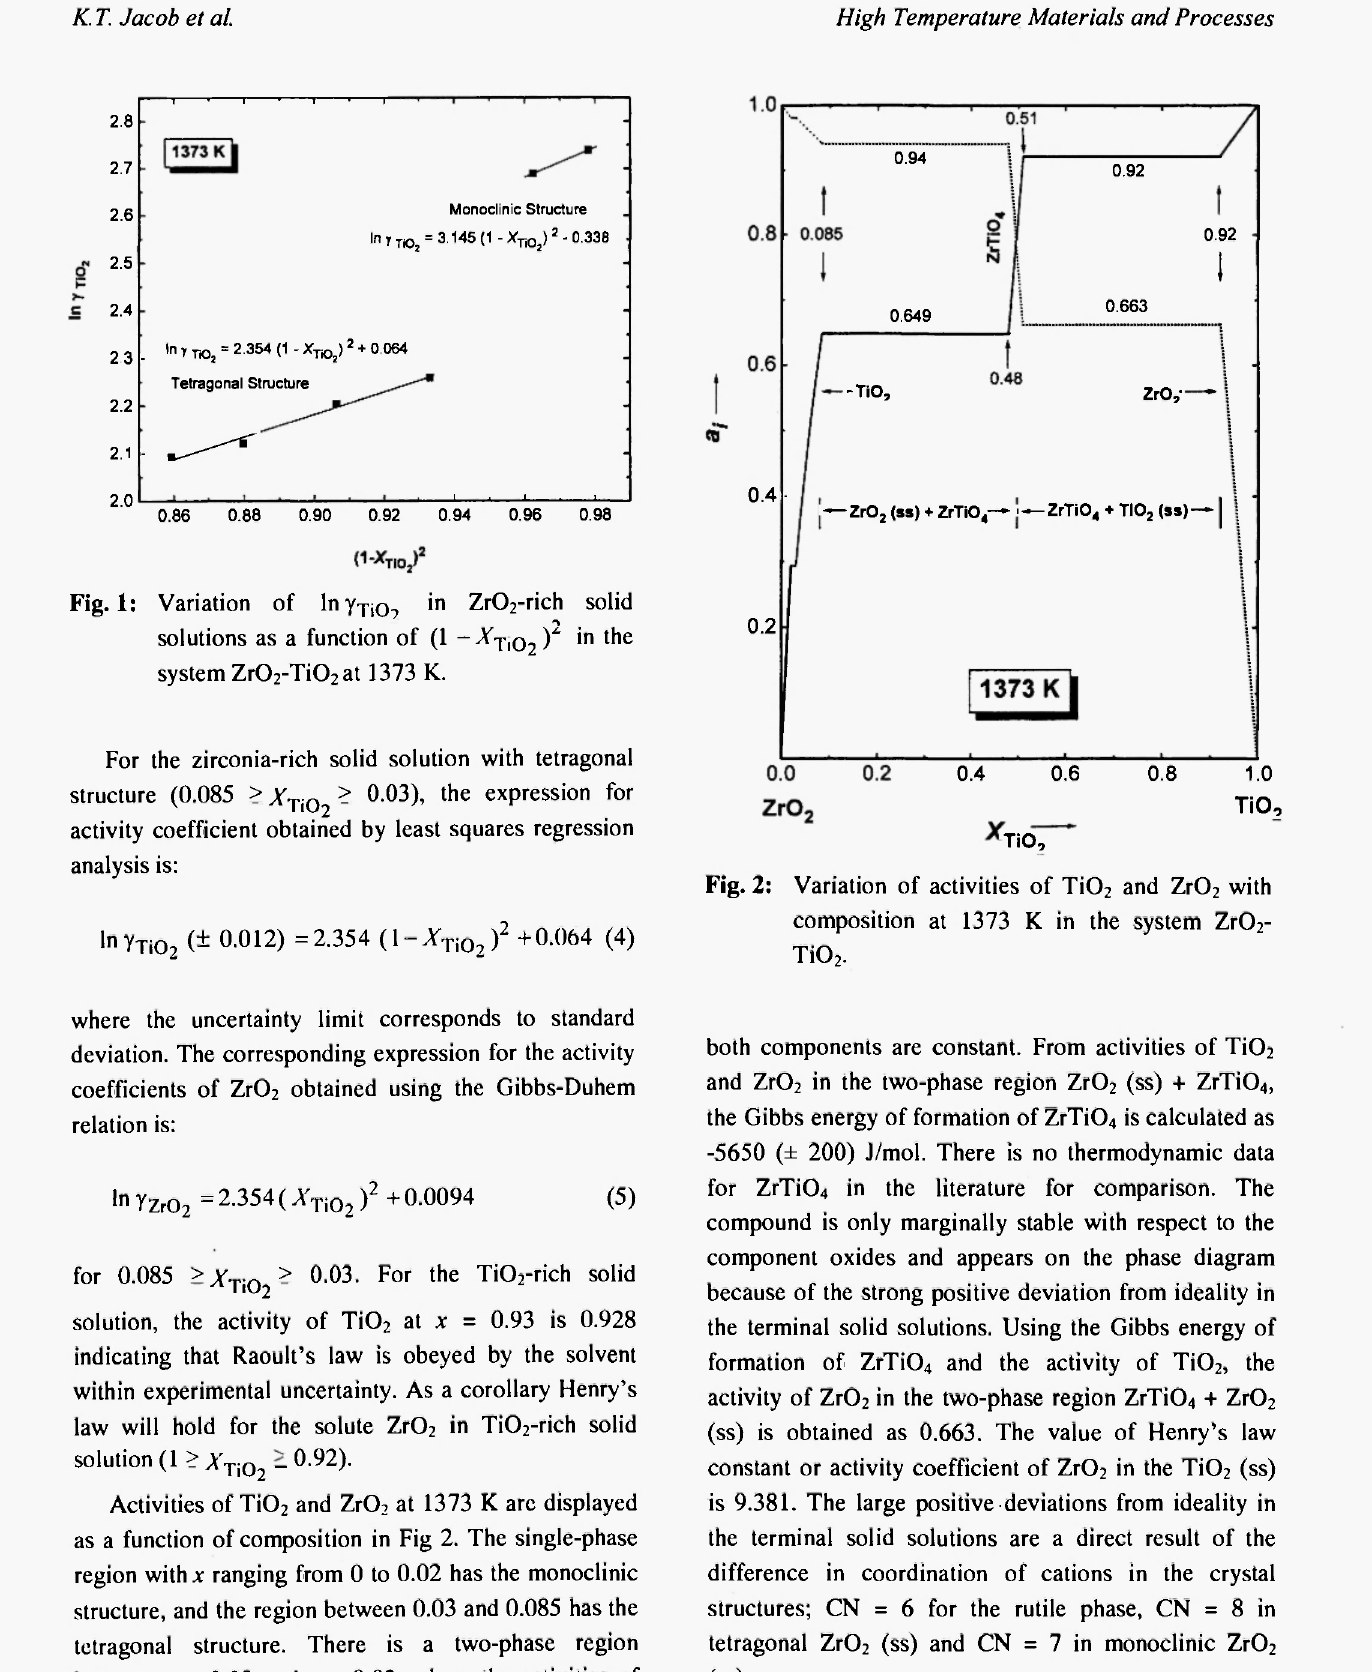
both components are constant. From activities of Ti0 2 and Zr0 2 in the two-phase region Zr0 2 (ss) + ZrTi0 4 , the Gibbs energy of formation of ZrTi0 4 is calculated as -5650 (± 200) J/mol. There is no thermodynamic